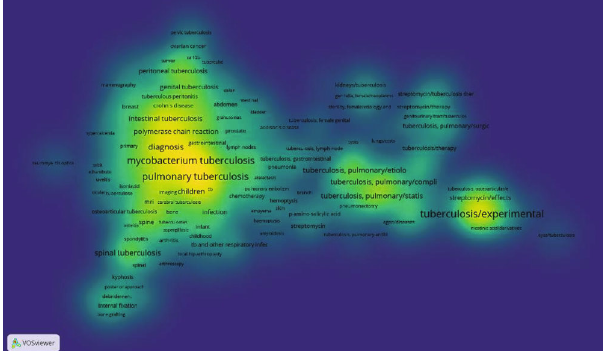
Figure 4: Densities of keywords in the topic “ Diagnosis and treatment ” in scienti fi c articles on tuberculosis.